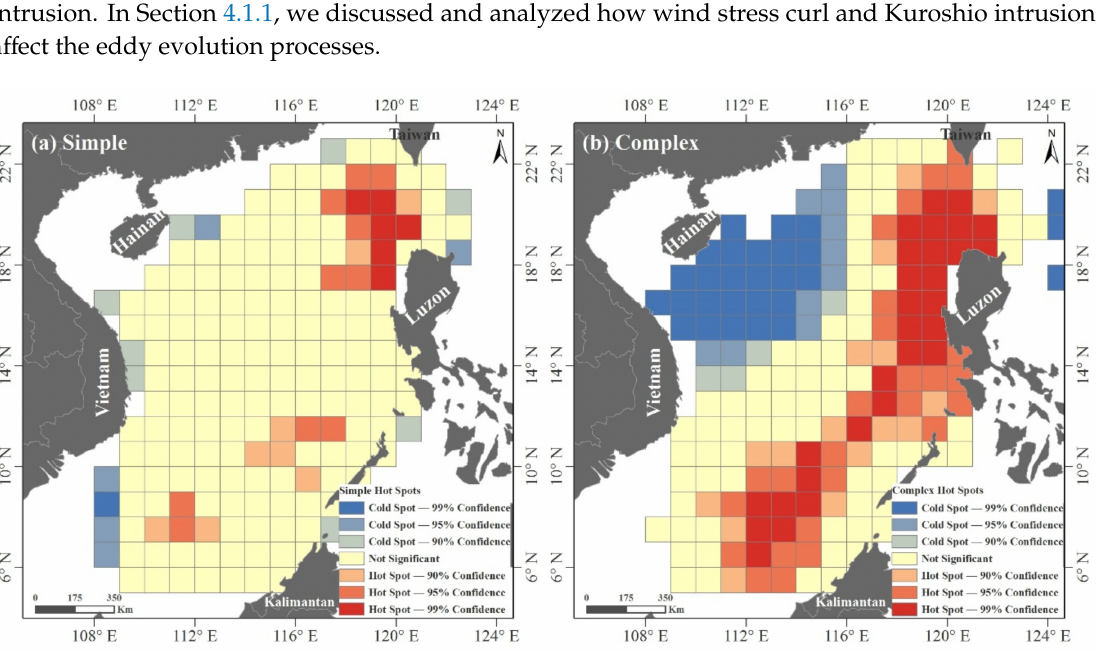
Figure 5. The hot and cold spots of the simple ( a ) and complex eddy processes ( b ).